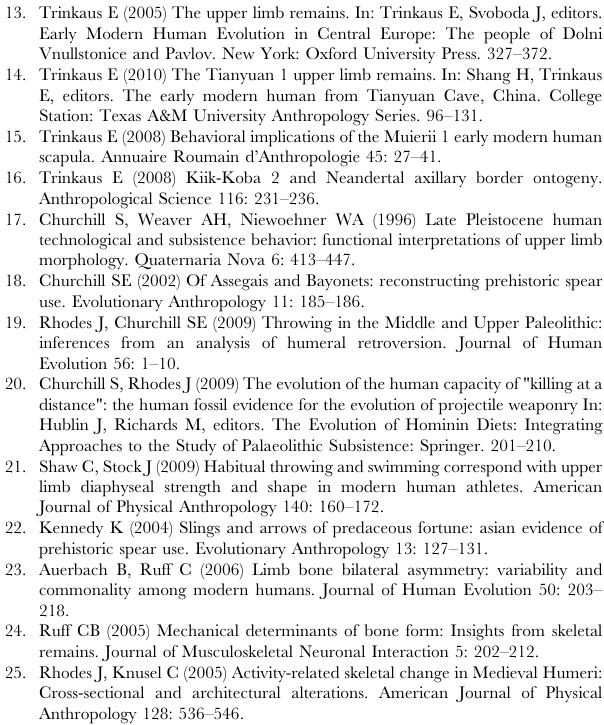
Figure S1 Electrode placement. Left to right: left posterior deltoid , left infraspinatus , right infraspinatus , right posterior deltoid , right anterior deltoid , right pectoralis major , left pectoralis major , left anterior deltoid . Figure S2 Experimental set up for spearing tasks. Figure S3 Chisel (top) and mini-crowbar utilized in the hack and vertical pull down scraping tasks, respectively. Figure S4 Experimental setup for the hack task . Figure S5 Experimental setup for the vertical pull down scraping task.